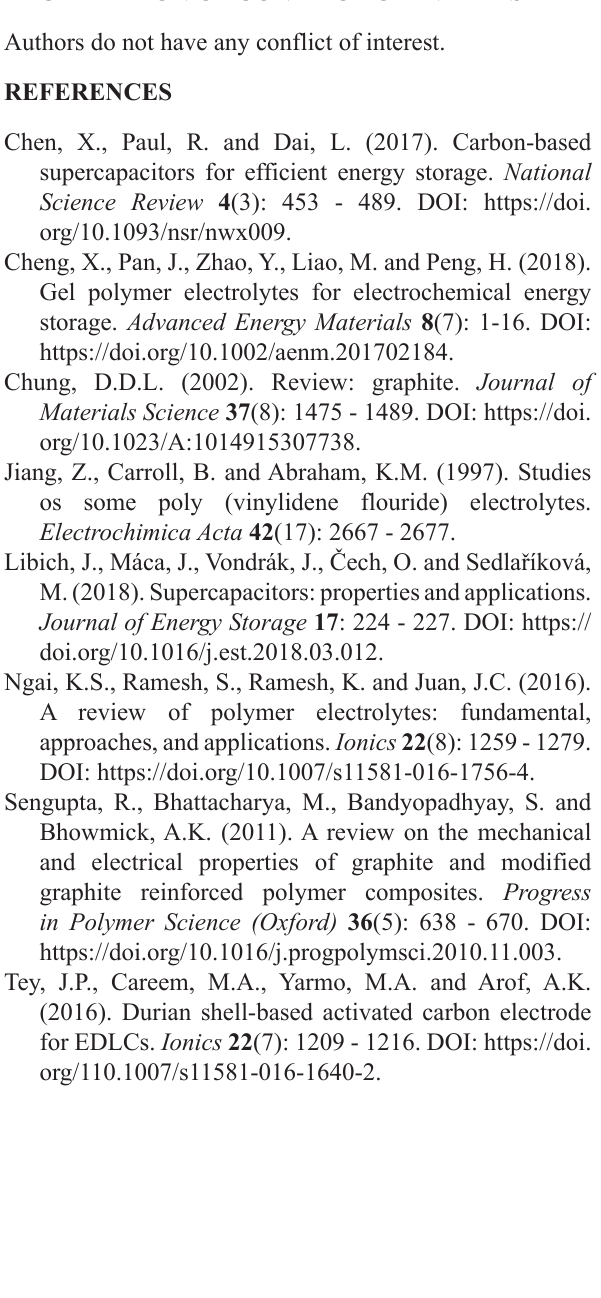
Figure 4 : Single electrode specific discharge capacitance ( C variation with the cycle